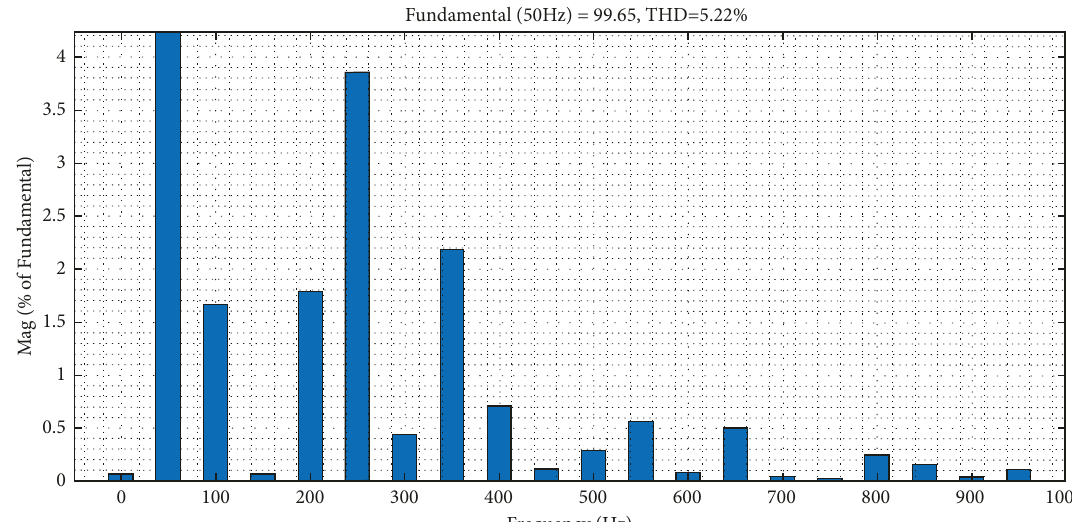
Figure 7: Current THD of AC grid side for PI with level-shifted